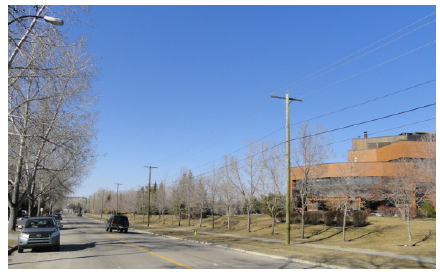
Figure 1. Hanging power cables in a road corridor in Canada Among the above applications, Ussyshkin and Smith (2007), for instance, modelled the transmission lines with a two-step process. In the first step, the azimuth of the power line was determined by fitting a straight line to the x and y coordinates. Then, the transformed x and the z coordinates were used to solve the conventional 2D equation of the catenary curve.